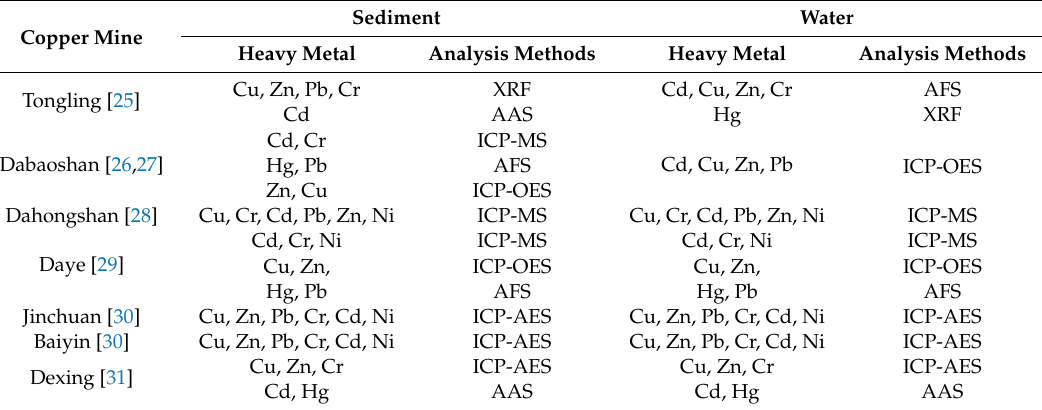
Table 1. Analysis methods of heavy metal elements used in seven papers.